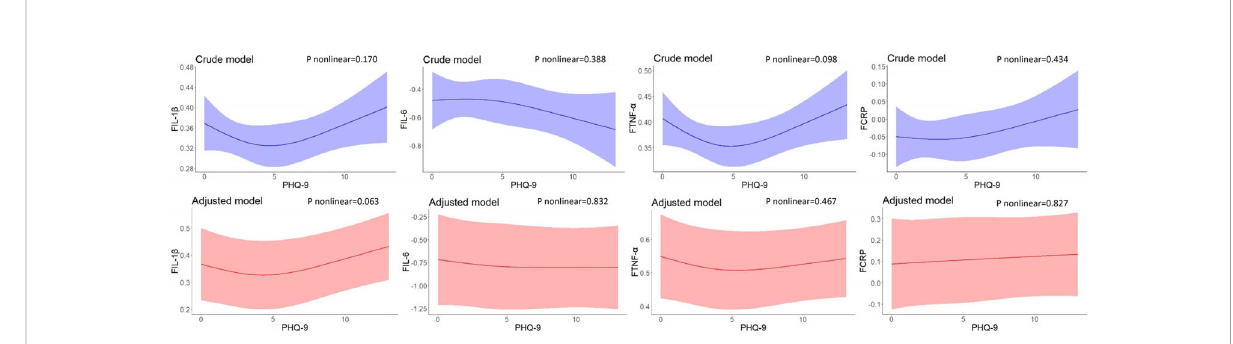
FIGURE 2 Restricted cubic spline models of the associations between PHQ-9 scores at baseline and in fl ammatory biomarkers at follow-up (n=248). IL-1 b , interleukin-1 b ; IL-6, interleukin-6; TNF- a , tumor necrosis factor- a ; CRP, C reactive protein. a The blue plot represented the crude model which was not adjusted by any variables, and the red plot represented the adjusted model which was adjusted by residential area, self-reported family economy, self-rated health condition, father ’ s education level, mother ’ s education level, cigarette use and alcohol use. b F represented 2-year